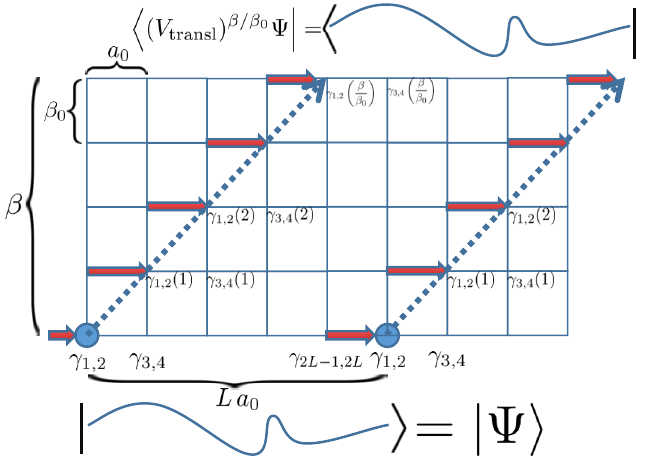
: the dash arrow points along the vector 1 ,s 2 f